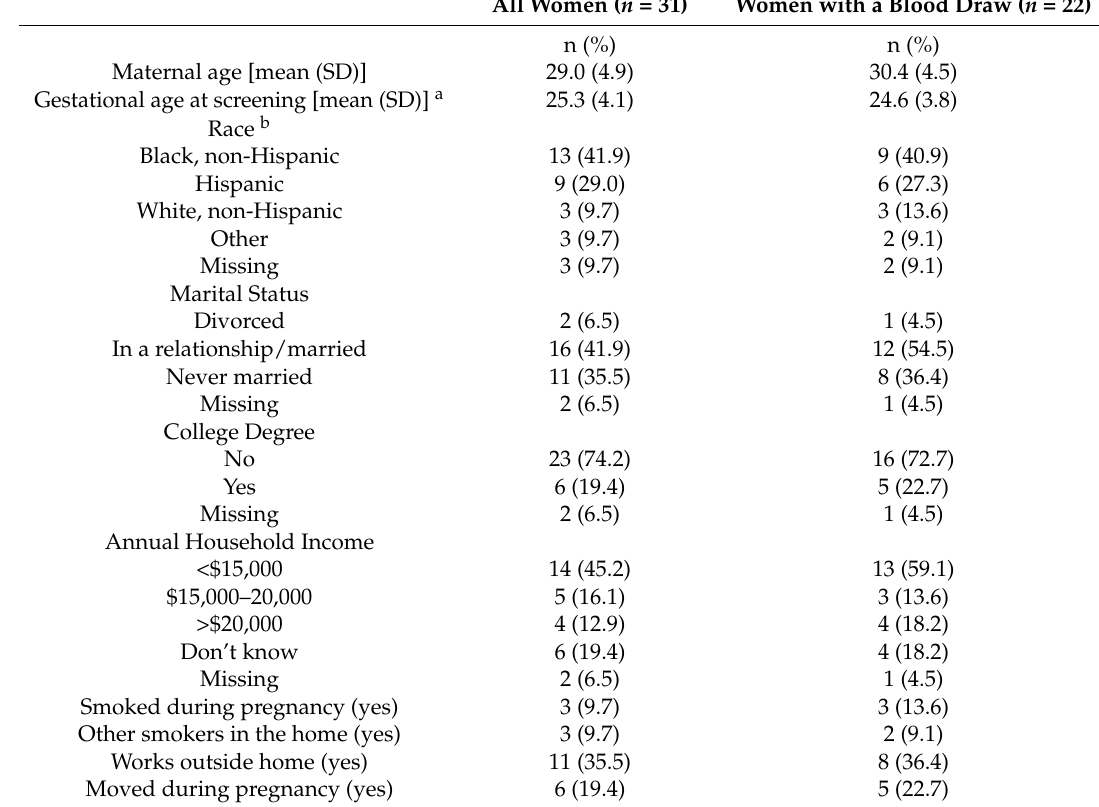
Table 1. Demographic characteristics of pregnant women attending a prenatal health clinic serving primarily Medicaid